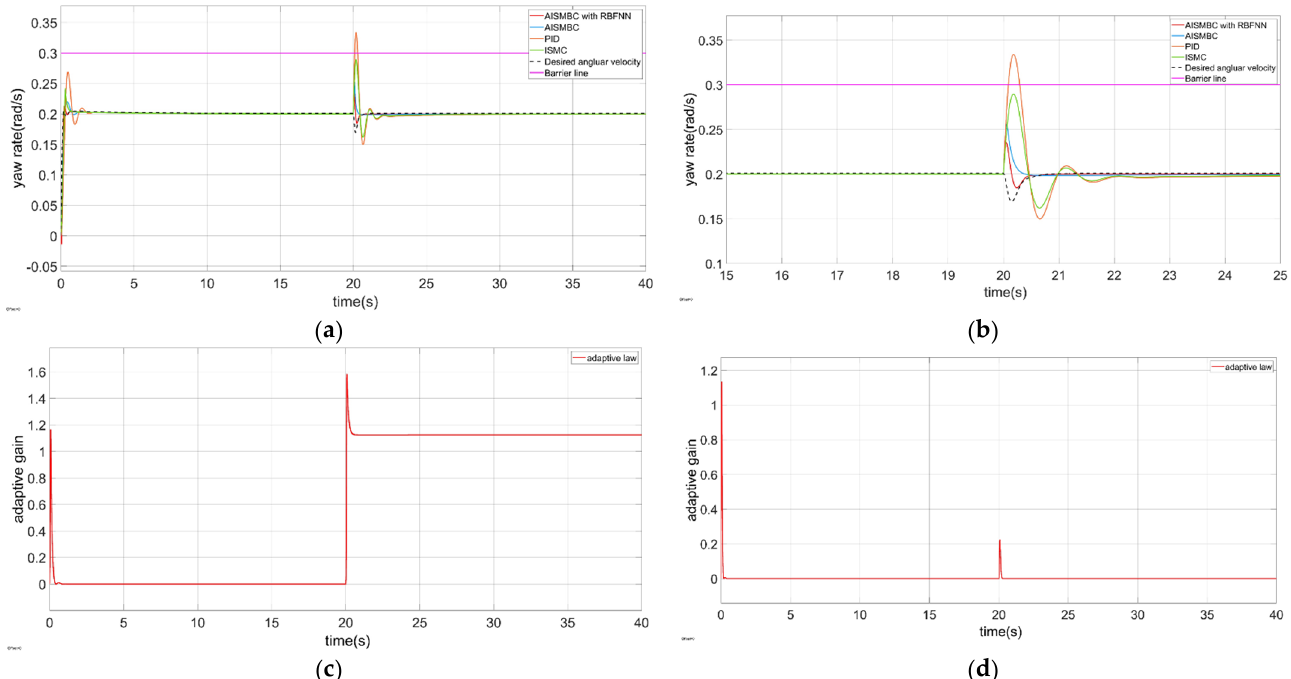
Figure 14. The yaw angle control. ( a ) The control results of yaw control with the three control methods. ( b ) The results of yaw angle tracking errors.